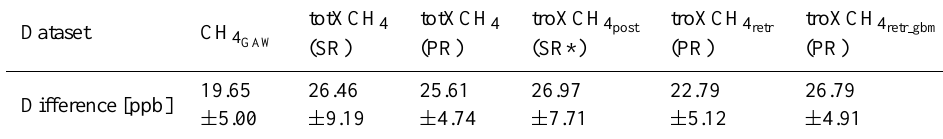
troXCH 4 troXCH 4 post retr retr gbm